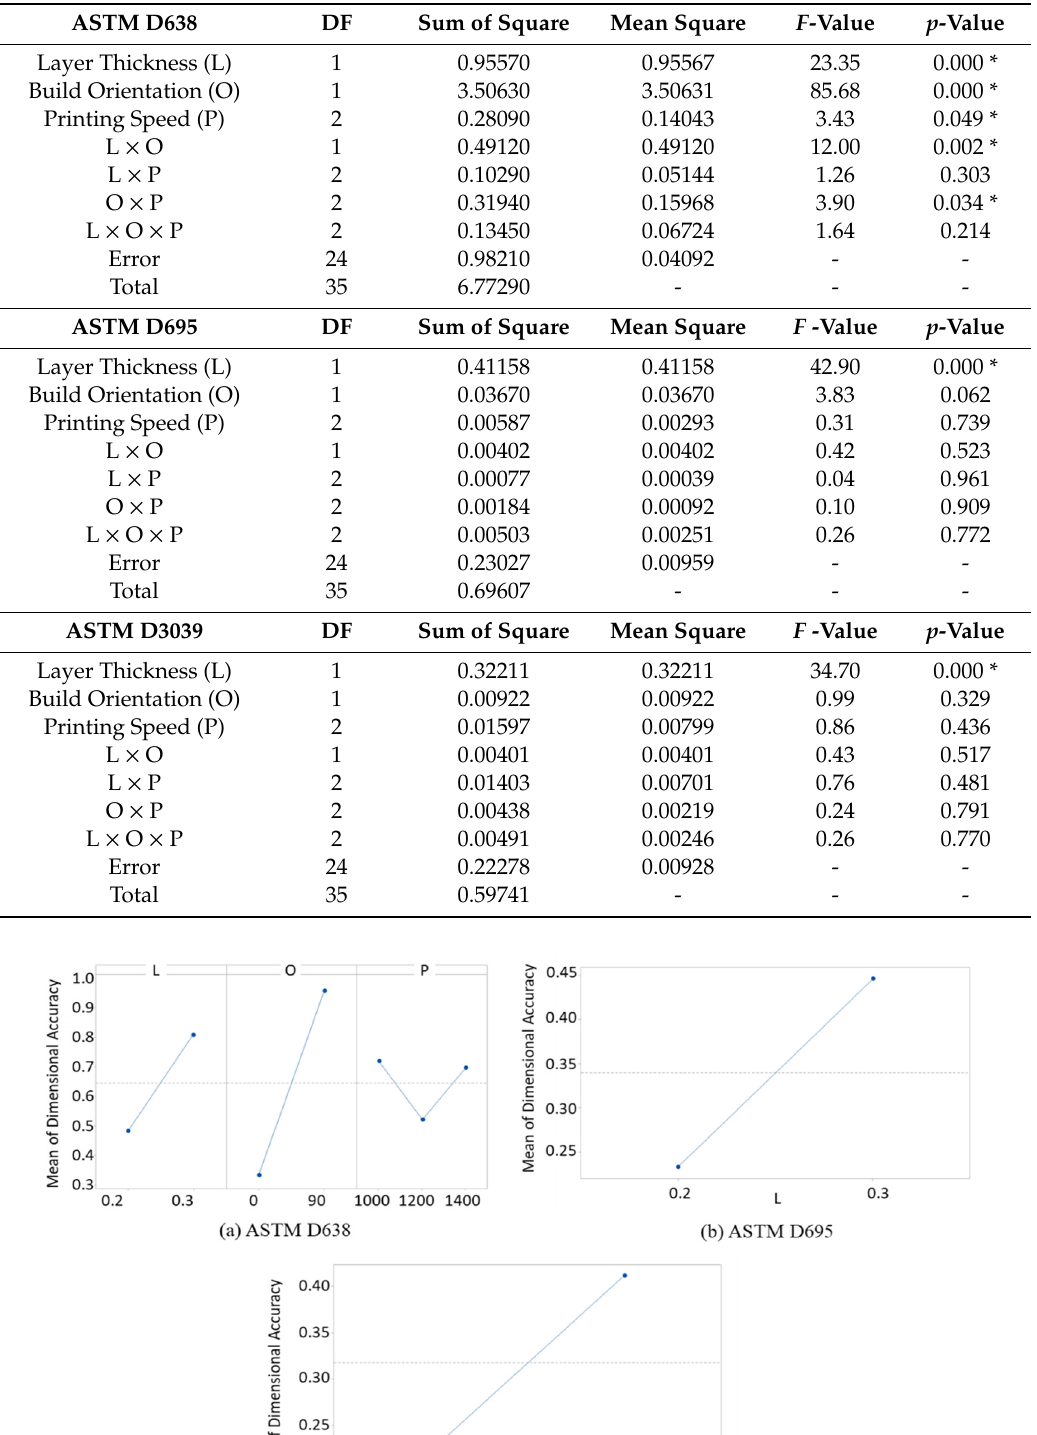
Table 8. ANOVA results for dimensional accuracy (* α < 0.05).